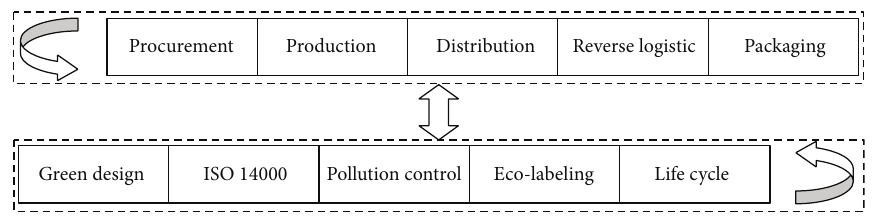
Figure 3: Detailed causal evaluation model.